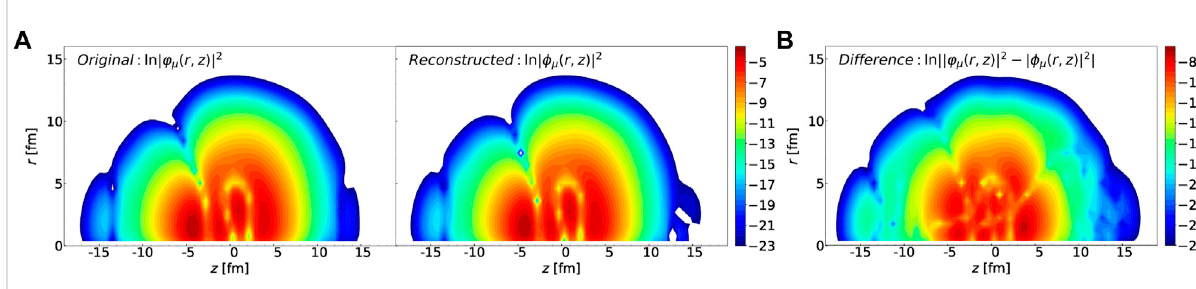
FIGURE 10 (A) :Contourplotofthelogarithmofthesquarednormoftheneutroncanonicalwavefunctionwithoccupationnumber v 2 μ (cid:1) 0 . 945255(without theexponentialfactor).Middle:Sameforthereconstructed wavefunction. (B) :Logarithmofthedifferencebetweenthesquarednormoftheoriginal and reconstructed wavefunctions.